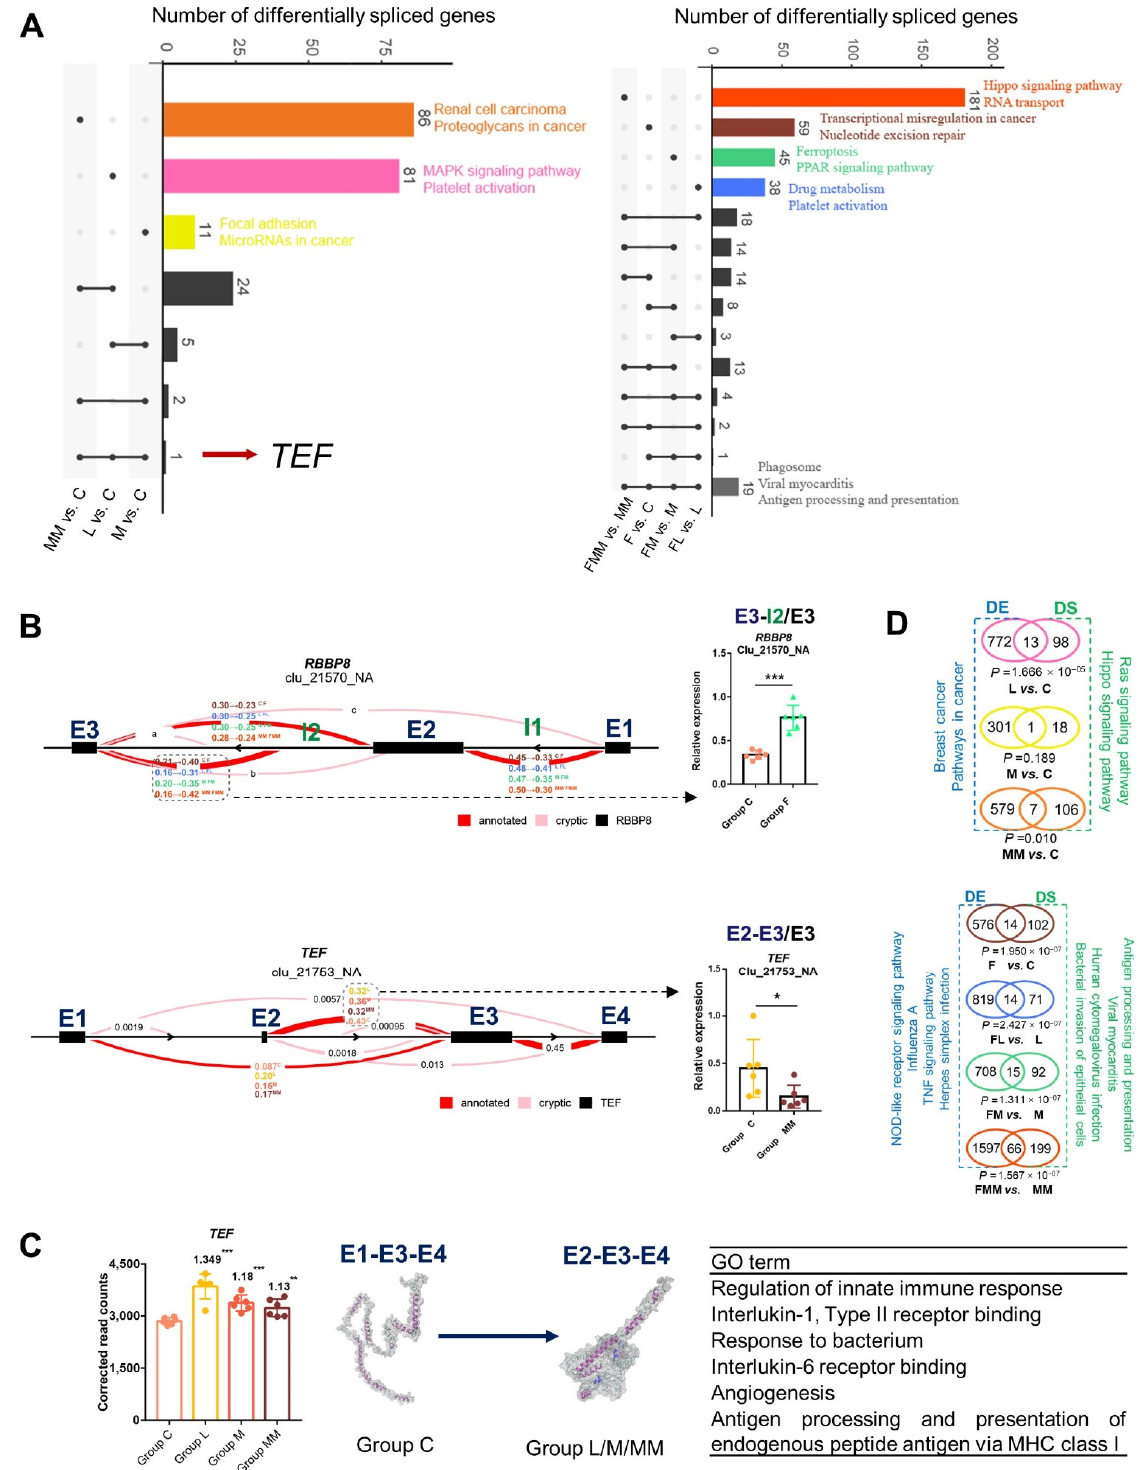
Figure 6. Differentially spliced genes and their relationship with DEGs. ( A ) Enriched KEGG pathways in common and unique differentially spliced genes among different comparison sets. ( B ) Alternative splicing types of the two common DS genes ( RBBP8 and TEF ) (left panel) and the corresponding expression levels of the part in the grey dotted box was verified by qRT-PCR (left panel). E: exon; I: intron. ( C ) Transcriptional expression of TEF in the four groups (left panel), predicted protein conformation of the two types of TEF DSs using I-TASSER (middle panel) and protein conformation of E2-E3-E4-related GO terms (right panel). ( D ) Relationship between DE and DS genes. Overlaps were tested by the hypergeometric test. The left and right sides are the respective pathways using DEGs and DSGs, respectively. * p < 0.01, ** p < 0.01, *** p <